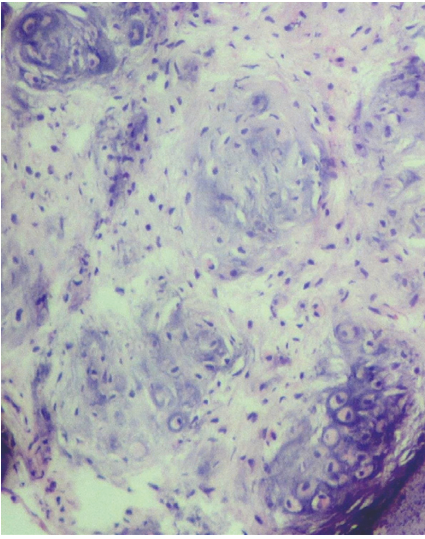
Figure 3: Photomicrograph showing lobulated mass of cartilagi- nous tissue (H&E,